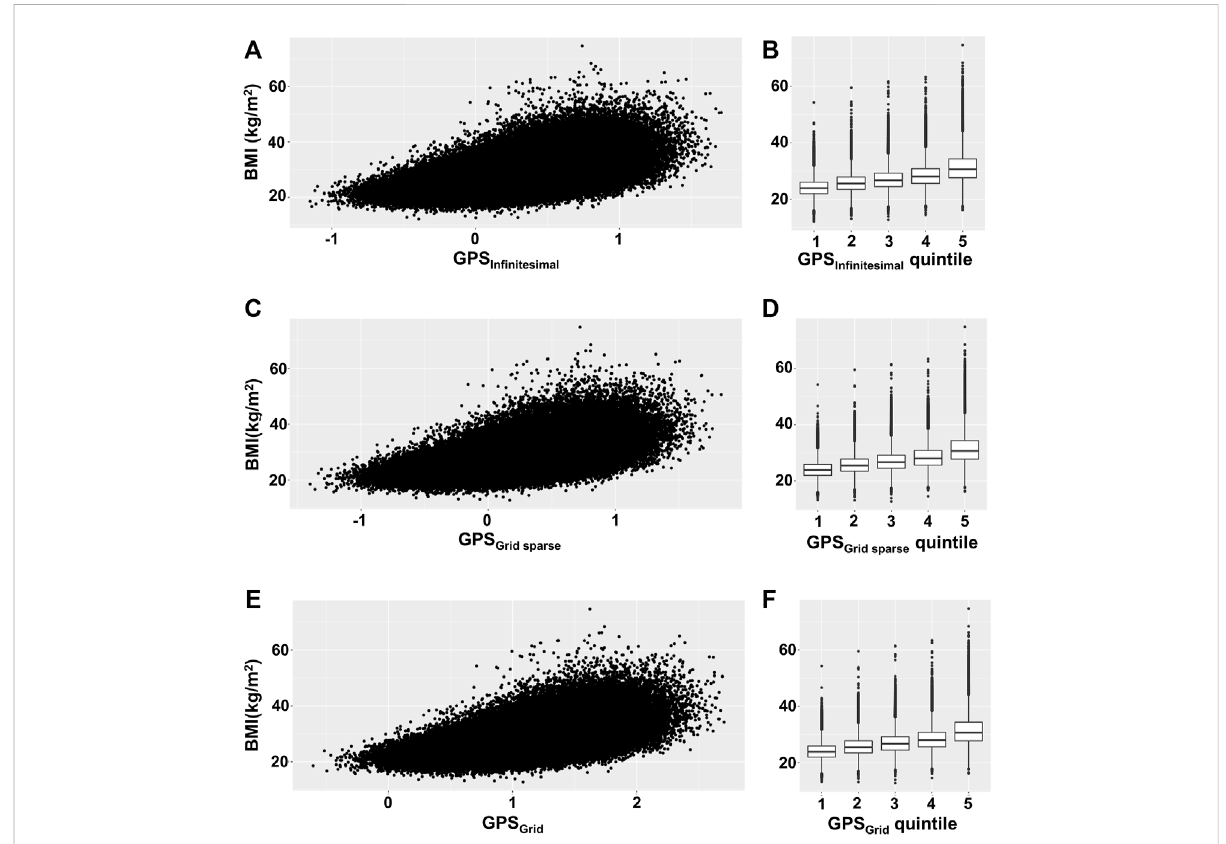
FIGURE 1 Scatterplot and box plot of BMI across GPS. (A,C,E) BMI was plotted against GPS for each GPS model, using the validation set. (B,D,F) The mean and variance of BMI were depicted by box plot per GPS quintile subgroup. (A,B) In fi nitesimal model using both test and validation sets, (C,D) grid sparse model using only the validation set, and (E,F) grid model using only the validation